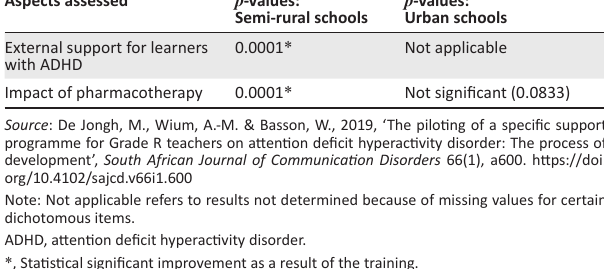
TABLE 4: Outcomes of participants’ knowledge on the management and support of attention deficit hyperactivity disorder. Aspects